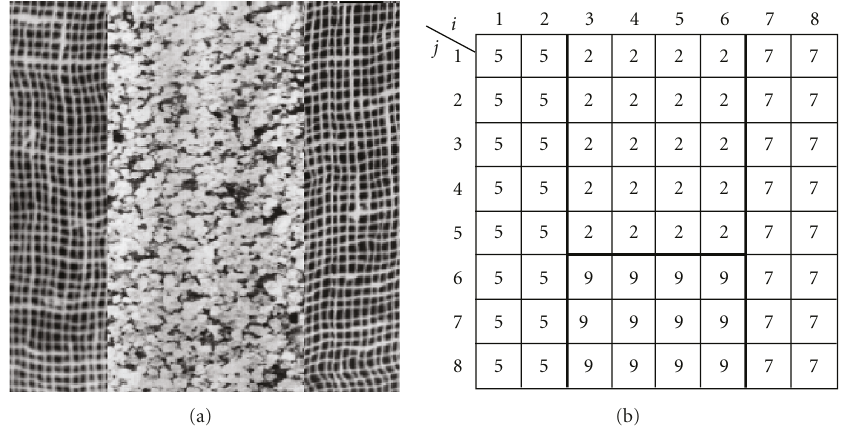
Figure 1: (a) A textured image. (b) A possible label configuration with the numbers representing the class